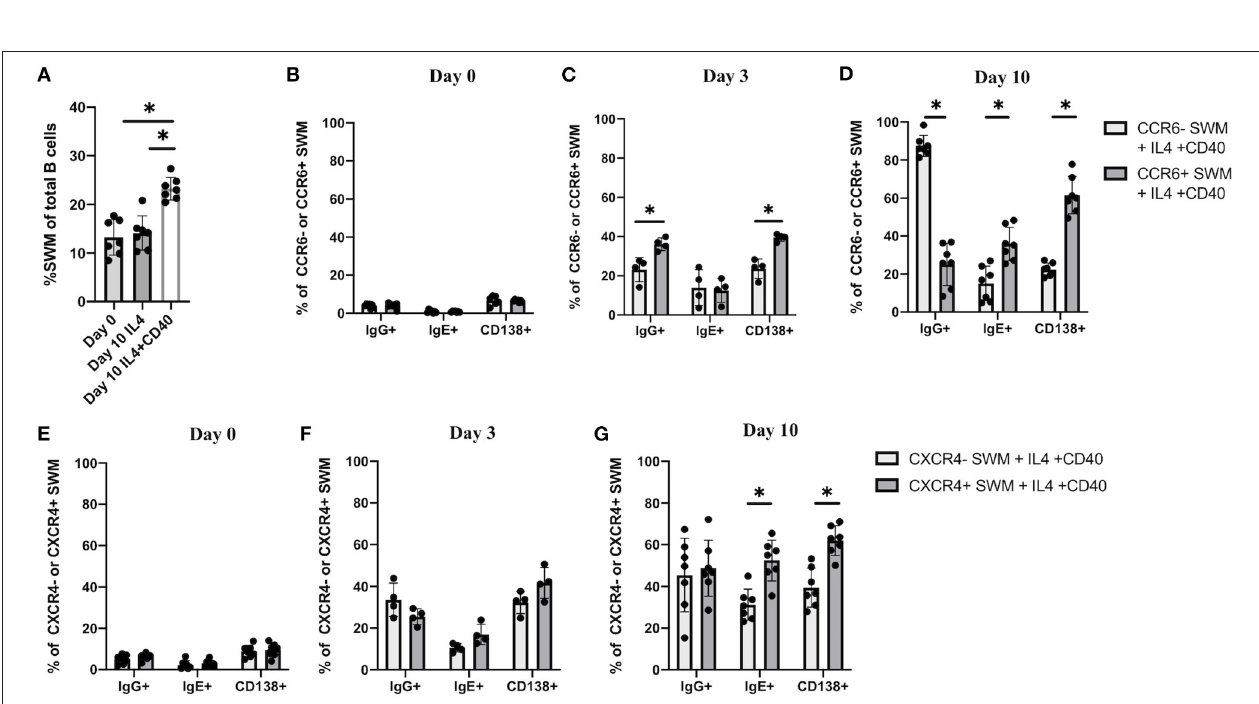
IgE expression was enhanced in CCL20 treated CCR6 + , but not CCR6- SWM B cells ( Figure 5A ). No differences in IgG surface expression were observed with CCL20 stimulation in either of CCR6- or CCR6 + SWM ( Figure 5B ). These results suggested